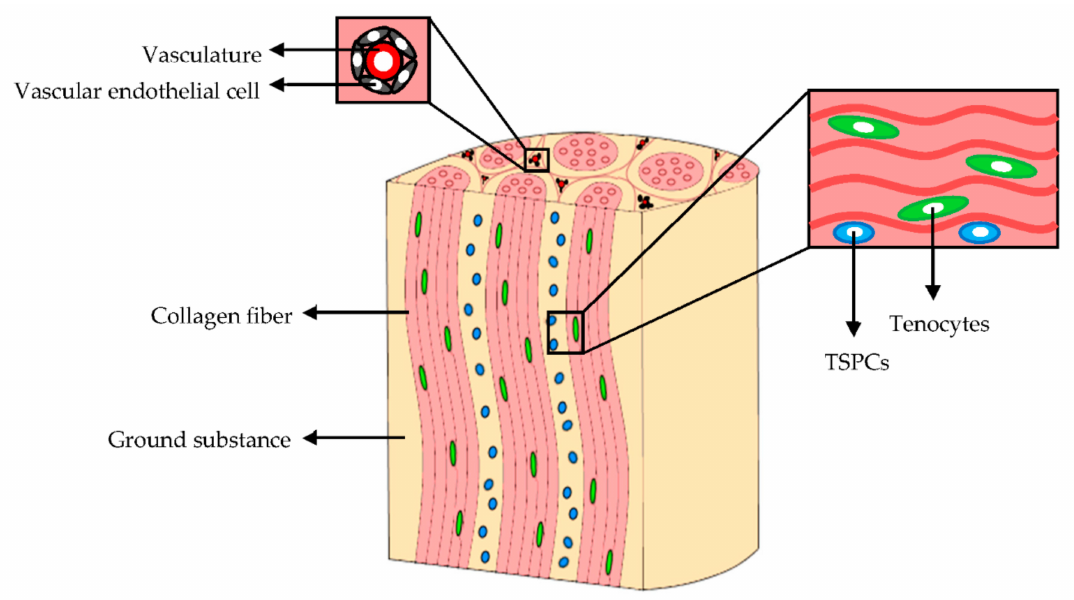
Figure 2. Extracellular matrix (ECM) and cellular components of tendons. Modified from [15]. CC BY